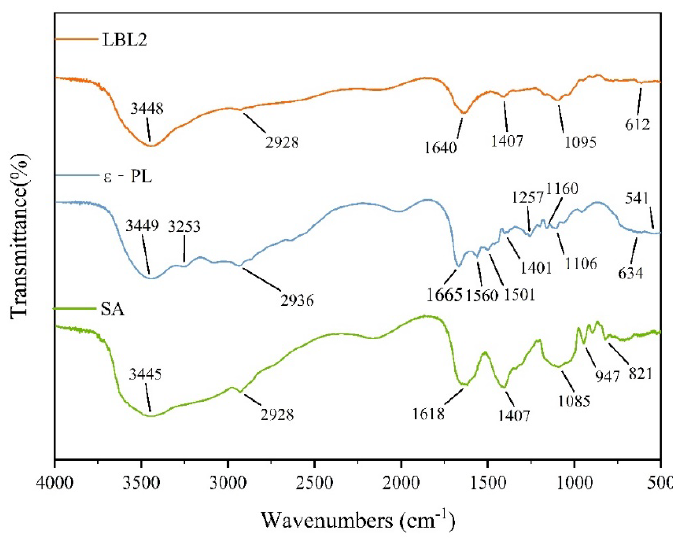
Figure 8. FT- IR of pure sodium alginate (SA), ε - polylysine (ε -PL), and LBL2